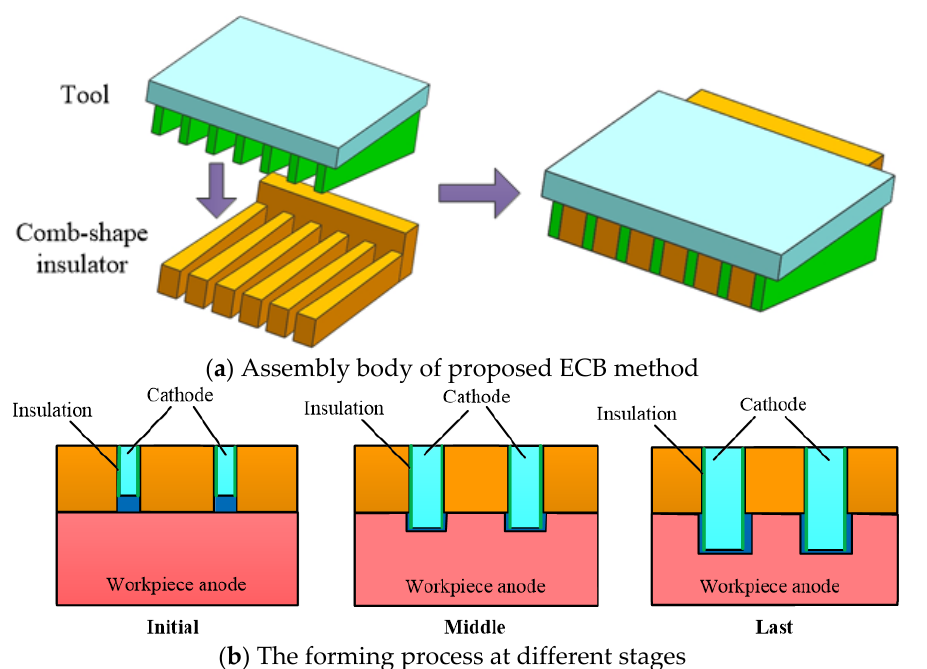
Figure 2. Schematic diagram of proposed ECB method for micro multi-grooves.